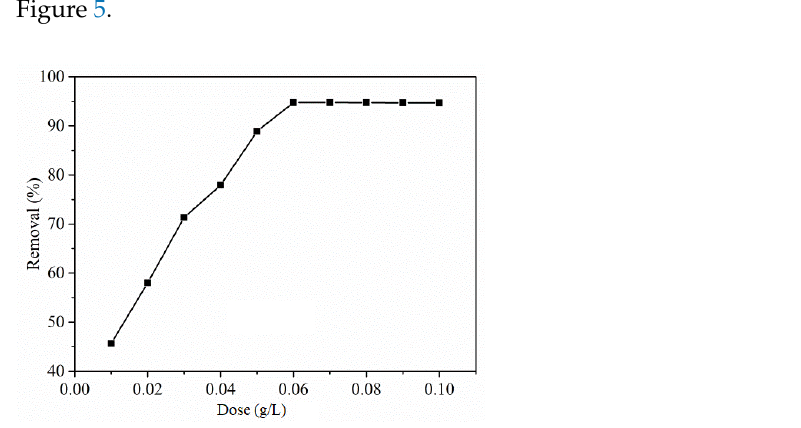
Figure 5. Effect of adsorbent dosage on the %removal efficiency with Cu(I)-PANI composite (initial concentration, pH, contact time, and volume of solution are 100 mg/L, 4, 90 min, and 100 mL, re- spectively).